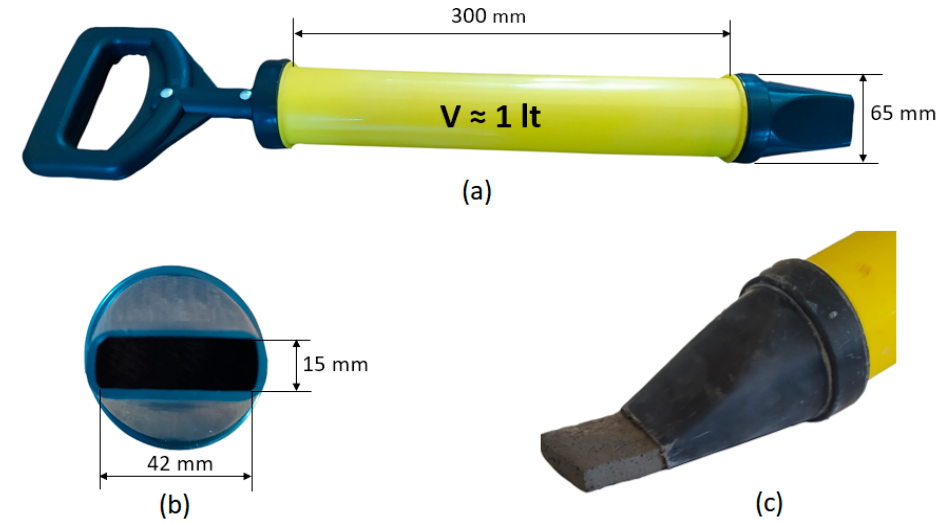
Figure 4. Mortar injection gun ( a ), the dimensions of the nozzle ( b ), and extrusion process ( c ).